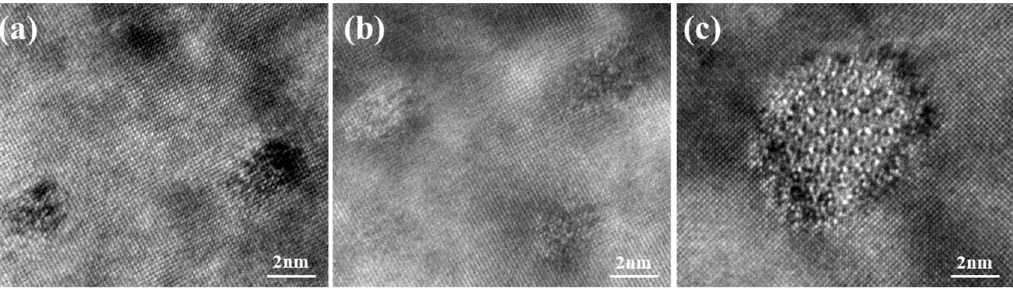
Figure 10. The high-resolution transmission electron microscopy (HRTEM) images of the sample after experienced different ageing treatments: ( a ) 160 °C at 600 min, ( b ) 175 °C at 480 min, ( c ) 190 °C at 180 min.